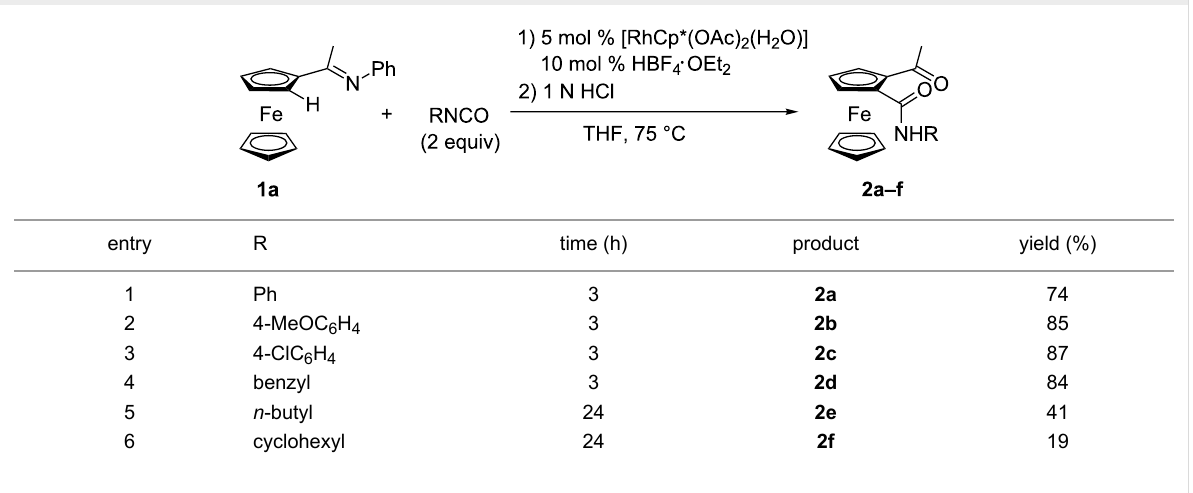
Table 2: Scope of isocyanates.